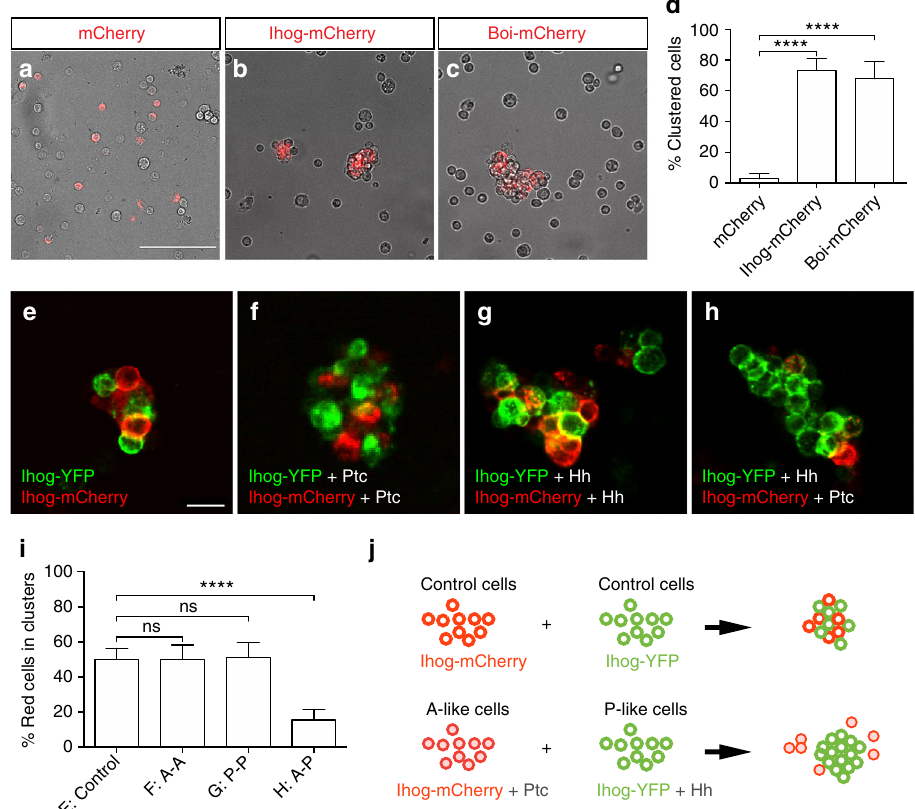
Fig. 7 S2 cells expressing Ihog and Ptc segregate from those expressing Ihog and Hh. a – c Drosophila non-adhesive S2 cells were transfected for expression of mCherry ( a ), Ihog-mCherry ( b ), or Boi-mCherry ( c ). Note the bright fi eld channel image shows both transfected and un-transfected S2 cells. S2 cells aggregate upon expression of Ihog-mCherry and Boi-mCherry, indicated by the cluster formation of transfected cells (mCherry expressing) under the exclusion of un-transfected cells. In contrast, the cells transfected by mCherry alone do not aggregate. Scale bar, 100 µ m. d The aggregation effect was quanti fi ed as the ratio of transfected cells within a cluster to total transfected cells. Each bar shows the mean ± s.d. from n = 20 different images, and representative images are shown in a , b , c , e – h . S2 cells were transfected separately with plasmids expressing Ihog-YFP/mCherry, Ihog-YFP/mCherry and Hh, or Ihog-YFP/mCherry and Ptc. Cells were dissociated by trypsin treatment and then mixed 4 h to allow aggregation to occur. Scale bar, 20 µ m. i Ratio of red (mCherry expressing) cells from within a cluster to total transfected cells in e – h . Each bar shows the mean ± s.d. from n = 20 different images, and representative images are shown in a , b , c , j . Model of differential aggregation of S2 cells expressing Ihog/Hh and Ihog/Ptc. Two-tailed unpaired Mann – Whitney U -test was used for statistical analysis. ns not signi fi cant. **** P <